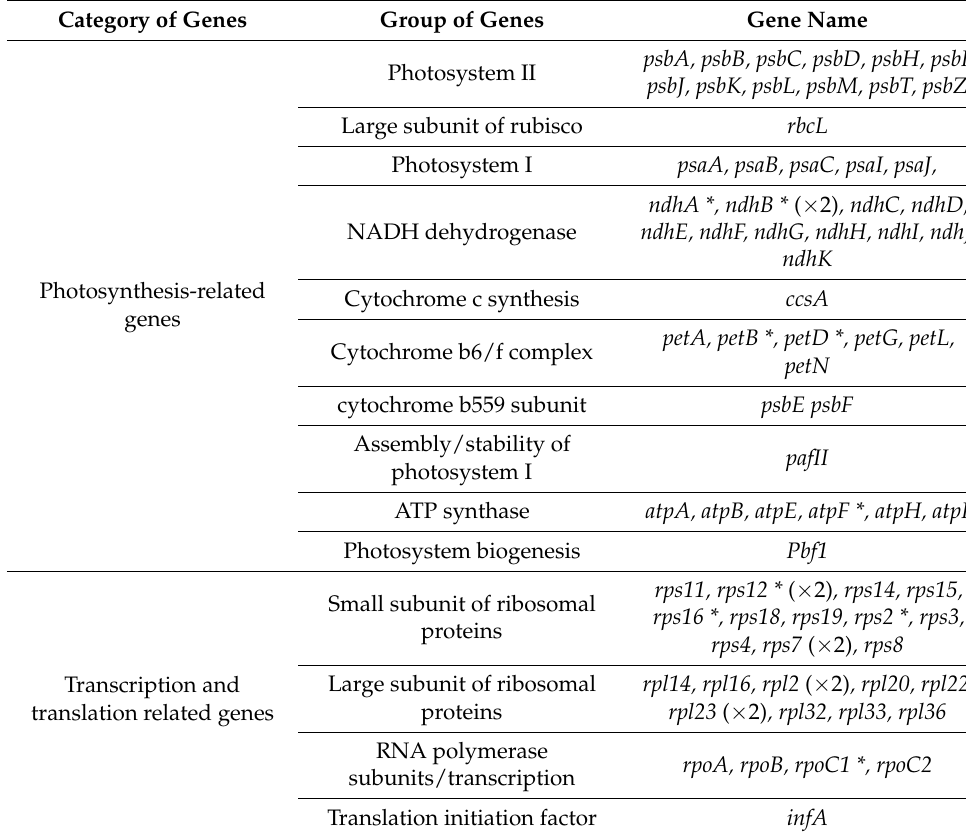
Table 2. Genes annotated in the chloroplast genome of A. frutescens